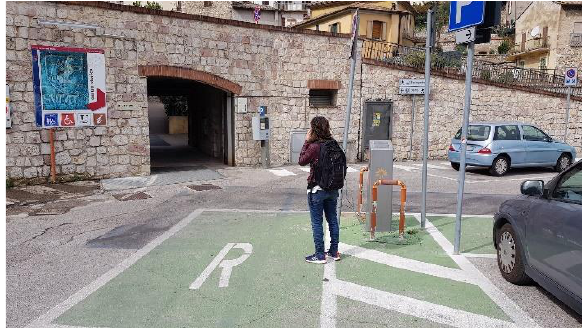
Figure 4. Data acquisition process in the case study.